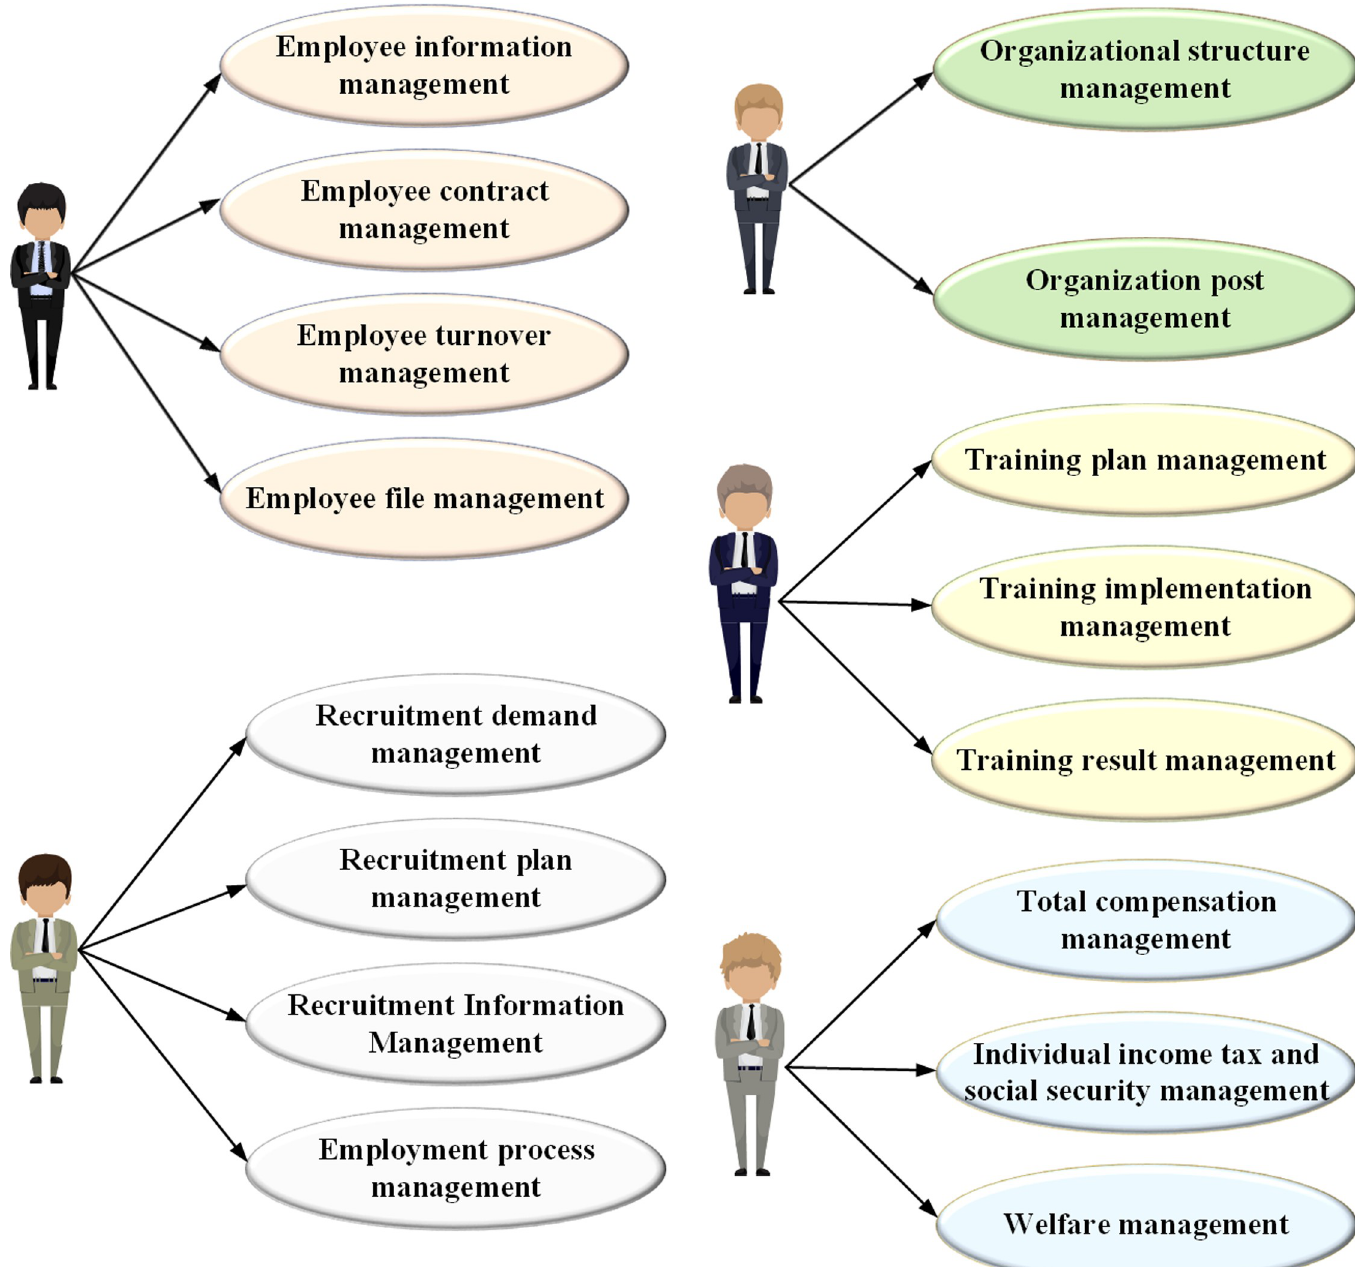
Fig 10. Use case diagrams for 5 major management modules (a. use case diagram of personnel management; b. use case diagram of organization management; c. use case diagram of recruitment management; d. use case diagram of training management; e. use case diagram of remuneration